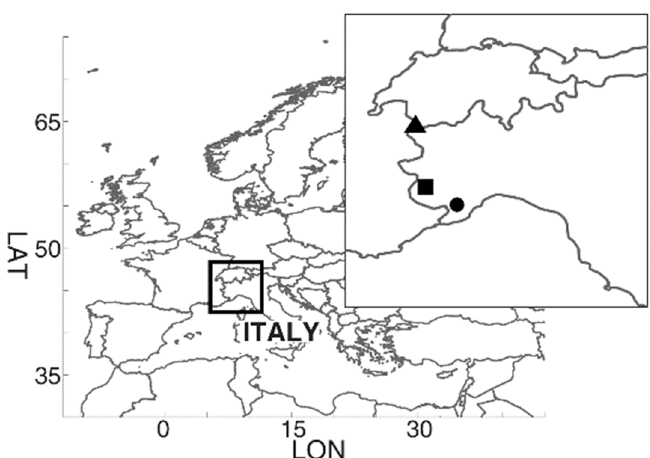
Figure 3. Locations of sites corresponding to the various datasets adopted. The black circle, square, and triangle correspond to Monesi di Mendatica, the Acceglio rock face, and the Mont de La Saxe landslide and Planpincieux glacier, respectively. This image was produced using the Matlab package borders [47].